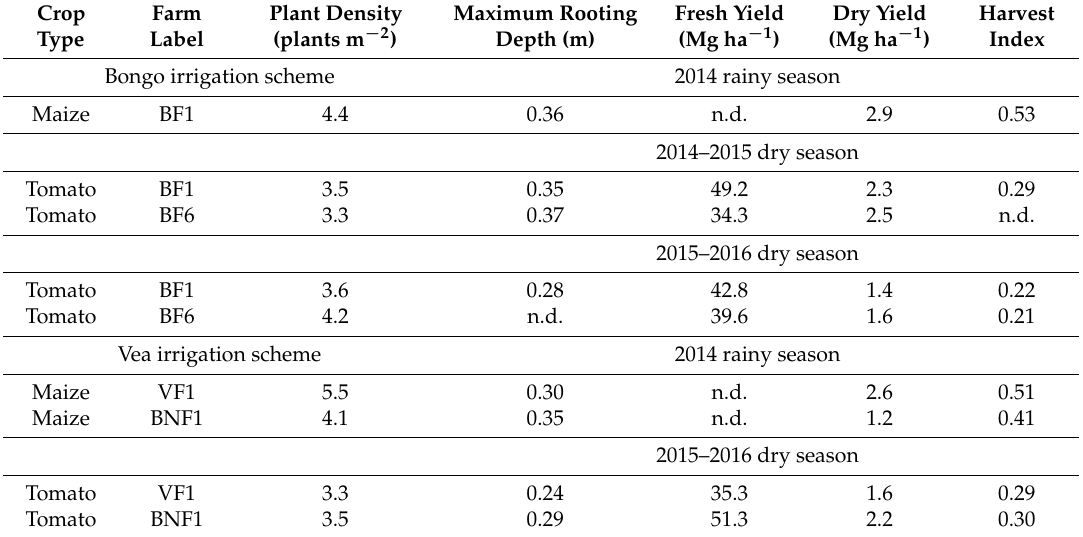
Table 3. Crop growth and yield components in the Bongo and Vea irrigation schemes during the 2014–2016 observation period.